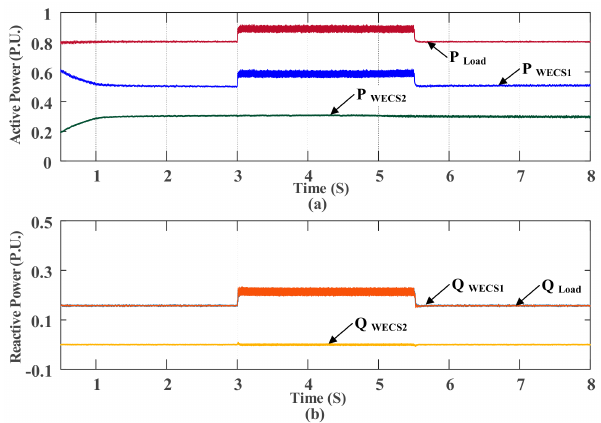
Figure 11. Inserting unbalanced load during autonomous mode: ( a ) Active power posture; ( b ) Reactive power